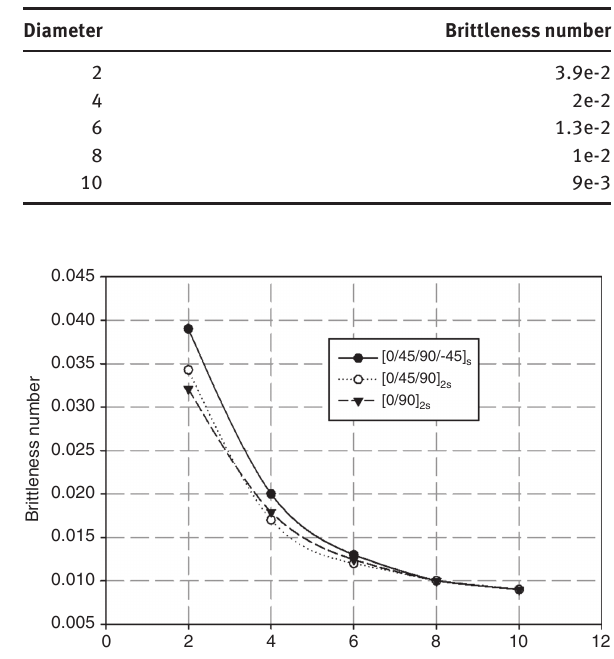
Table 14 Test results for [0/45/90/-45]